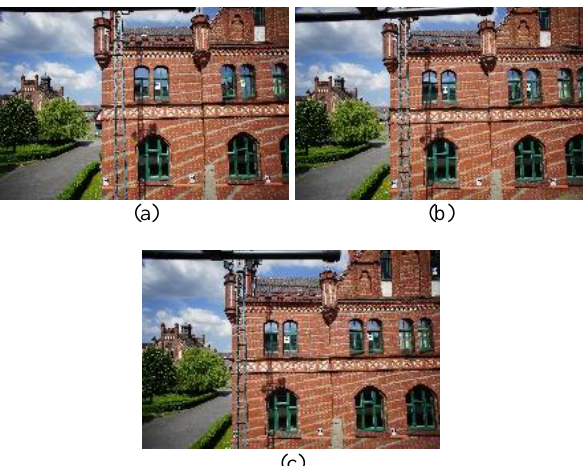
Figure 5. Selected images from the Zollern Colliery.